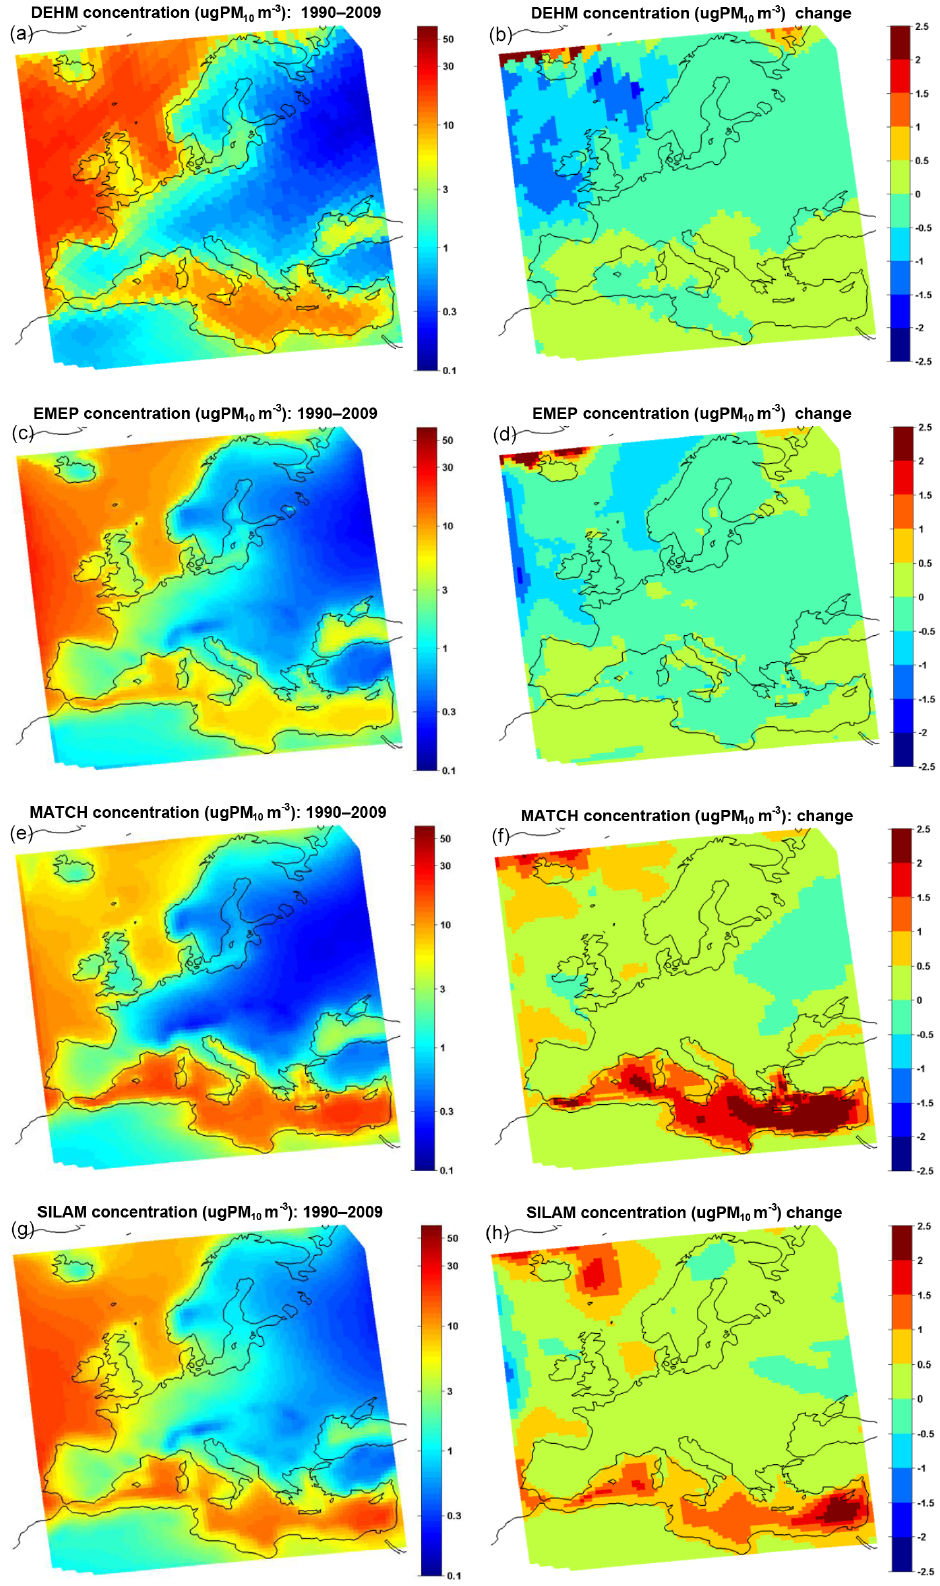
Figure 5. Sea salt surface concentration (µgPM 10 m − 3 ) for DEHM, MATCH, EMEP, and SILAM models. Left panels: mean value for the past period (1990–2009); right panels: absolute difference between the future (2040–2059) and past periods. www.atmos-chem-phys.net/16/13081/2016/ Atmos. Chem. Phys., 16, 13081–13104,